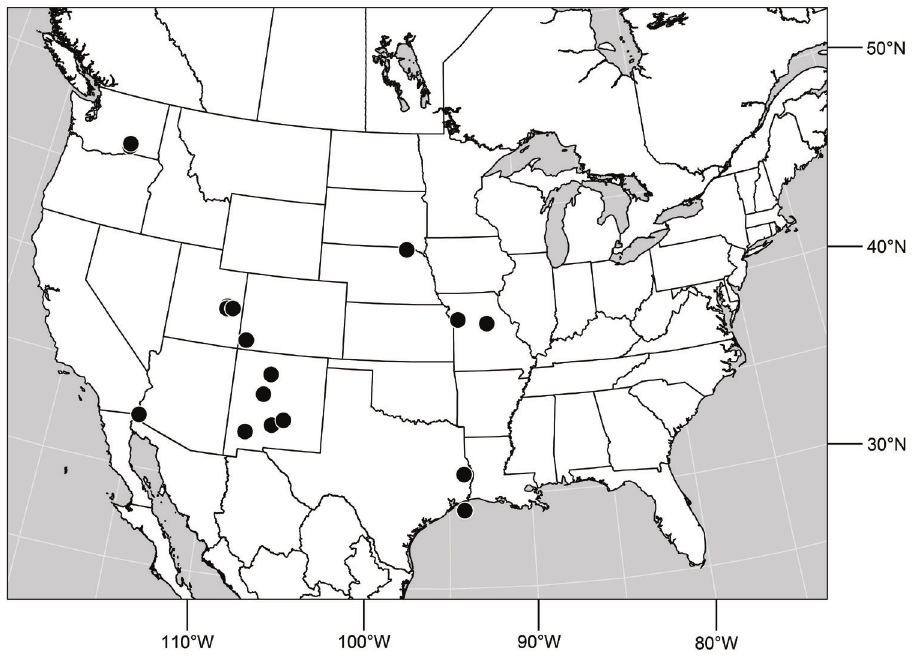
Figure 141. Distribution of Hydrochasma annae sp.